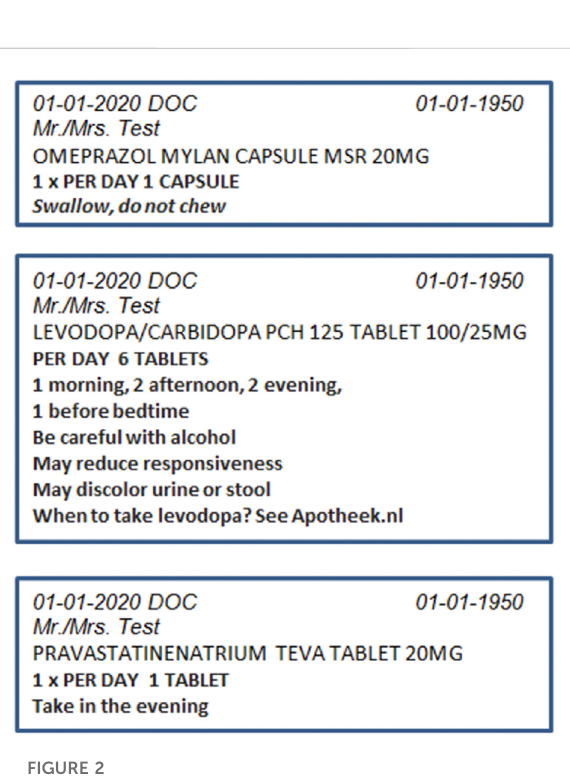
FIGURE 2 Prescriptiondruglabel1 –